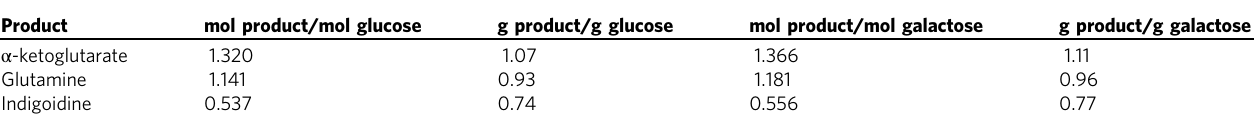
Table 1 Maximum theoretical yield of glutamine and indigoidine from two different substrates glucose and galactose with respect to stoichiometry and redox balance in P. putida